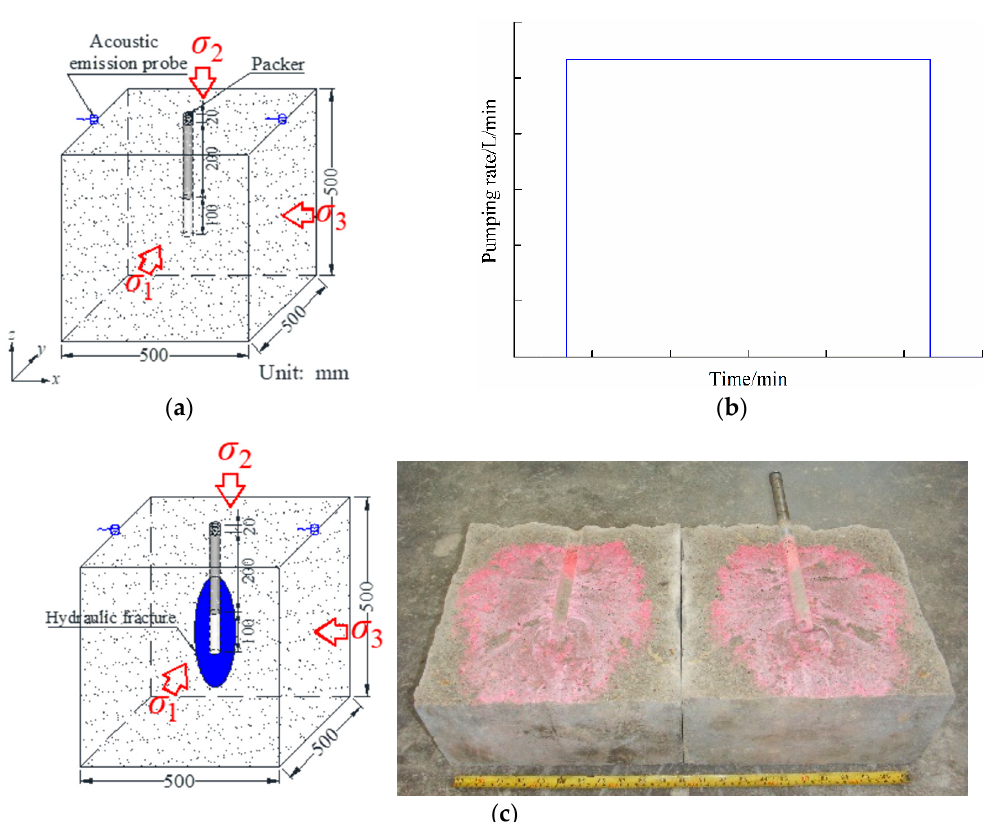
Figure 1. The conventional hydraulic fracturing performed by constant pumping rate: ( a ) cube test sample, ( b ) pumping process, and ( c ) hydraulic fracture morphology.